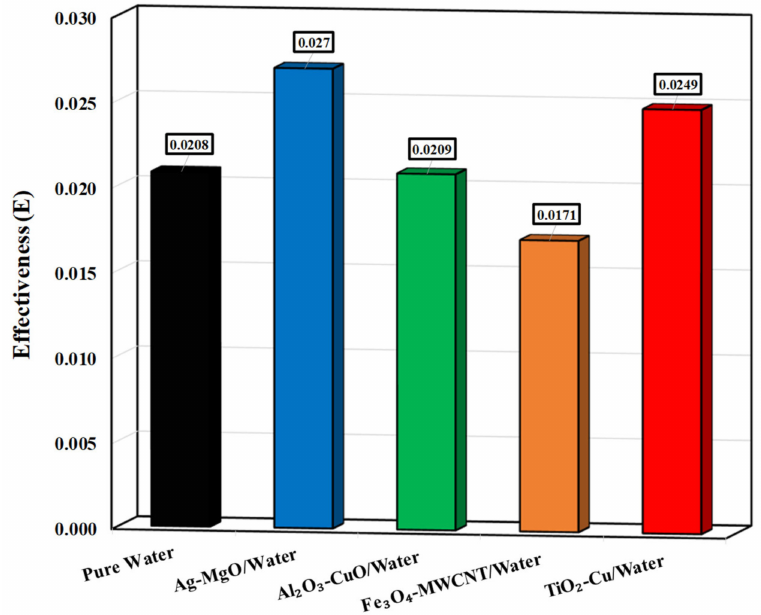
Figure 5. Effectiveness for various hybrid nanofluids at φ = 0.15 and Re = 3200.